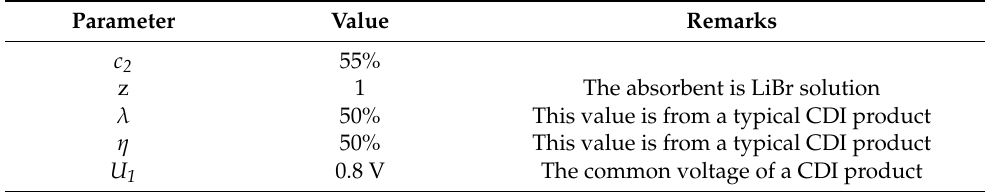
Table 1. Parameters for COP